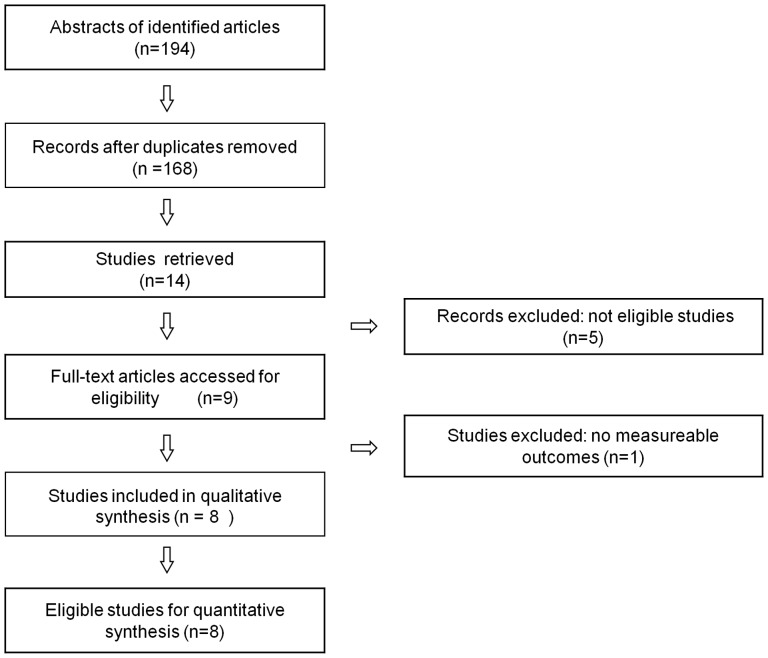
Flow chart of literature search and study selection.